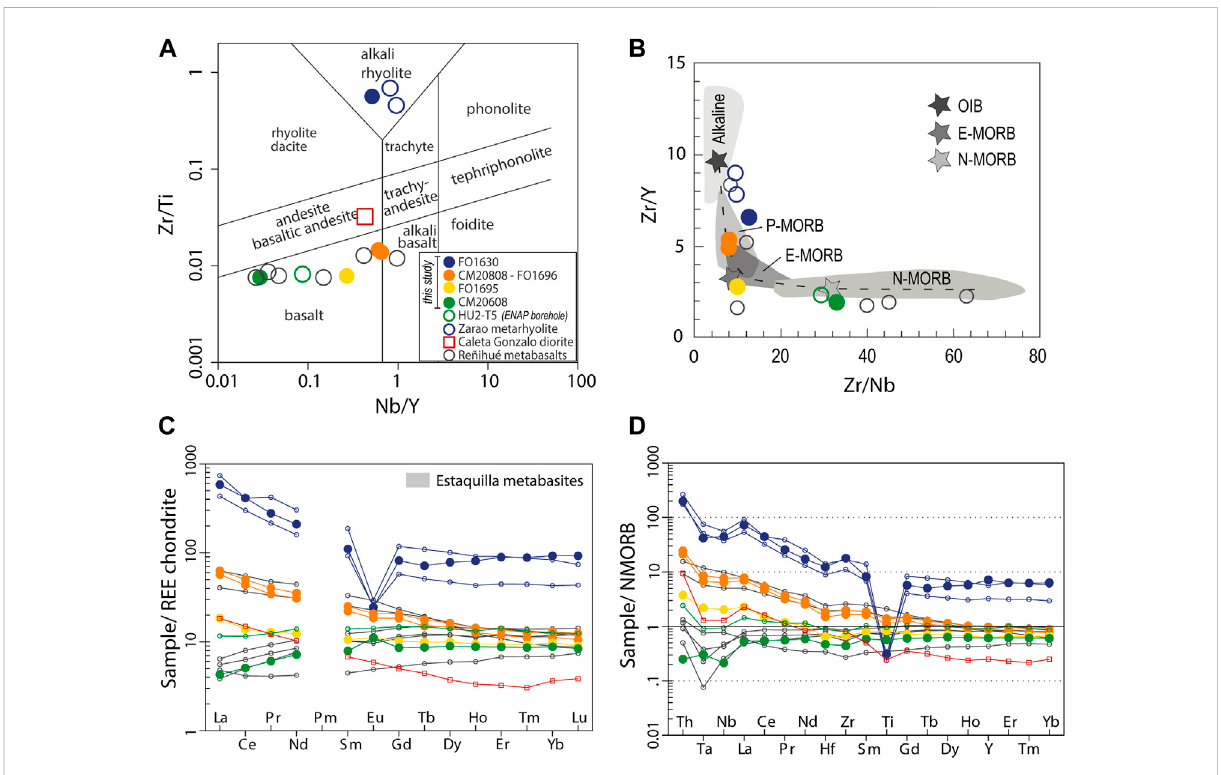
FIGURE 5 Solid circles correspond to the samples analyzed in this study. The open symbols correspond to the data obtained from the literature: Zarao metarhyolite, Caleta Gonzalo diorite, and Reñihue metabasalts (see Figure 1A for the location) are from the work of Rapela et al. (2021), and HU2-T5 metabasalt (see Figure 1B for borehole location) is from the work of Quezada (2015). (A) Zr/Ti vs. Nb/Y classi fi cation diagram (Winchester and Floyd, 1977;modi fi edbyPearce, 1996). (B) Zr/Y vs. Zr/Nb diagramfor metabasalts and metarhyolitesanalyzed. The composition of N-MORB, E-MORB, and OIB is from the work of Sun and McDonough (1989). Composition of fi elds for N-MORB, E-MORB, P-MORB, and alkaline (ocean-island basalts) and the dashed line representing the mixing curve between the OIB and N-MORB end members is from Saccani et al. (2014) and references therein. (C) REE spider diagram normalized to chondrite (Boynton, 1984). The gray fi eld of the Estaquilla Metabasites is after Crignola et al. (1997). (D) Multi- element spider diagram normalized to the N-MORB composition of Sun and McDonough (1989), following the criteria proposed by Pearce